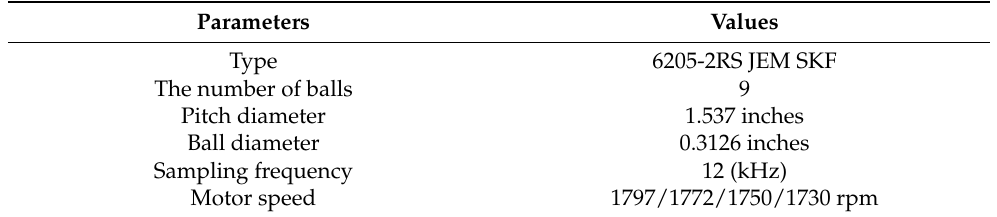
Table 9. Details of the test bearing.